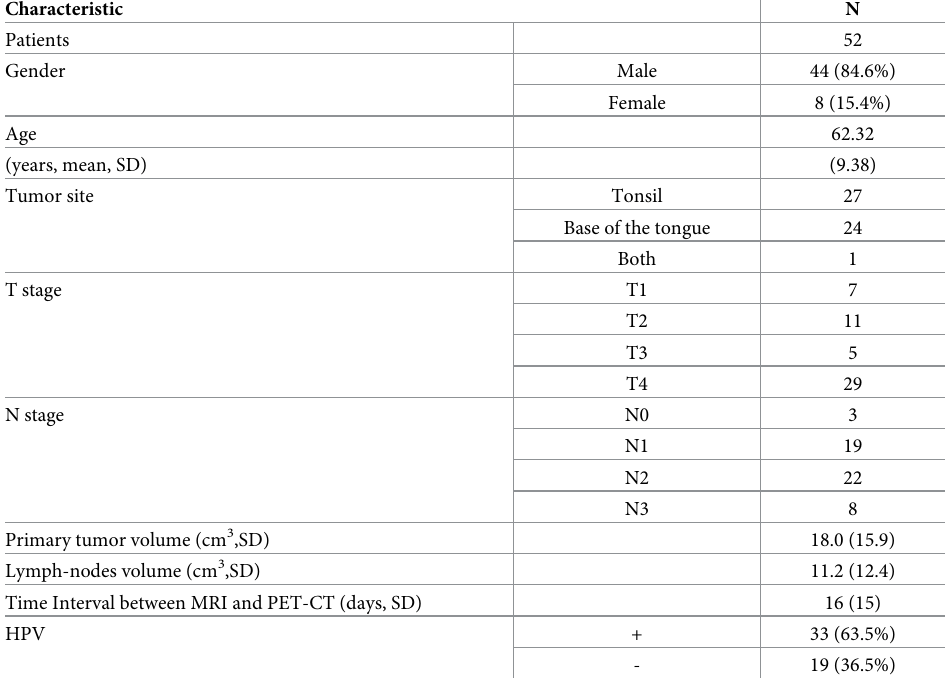
Table 1. Patient and tumor characteristics.